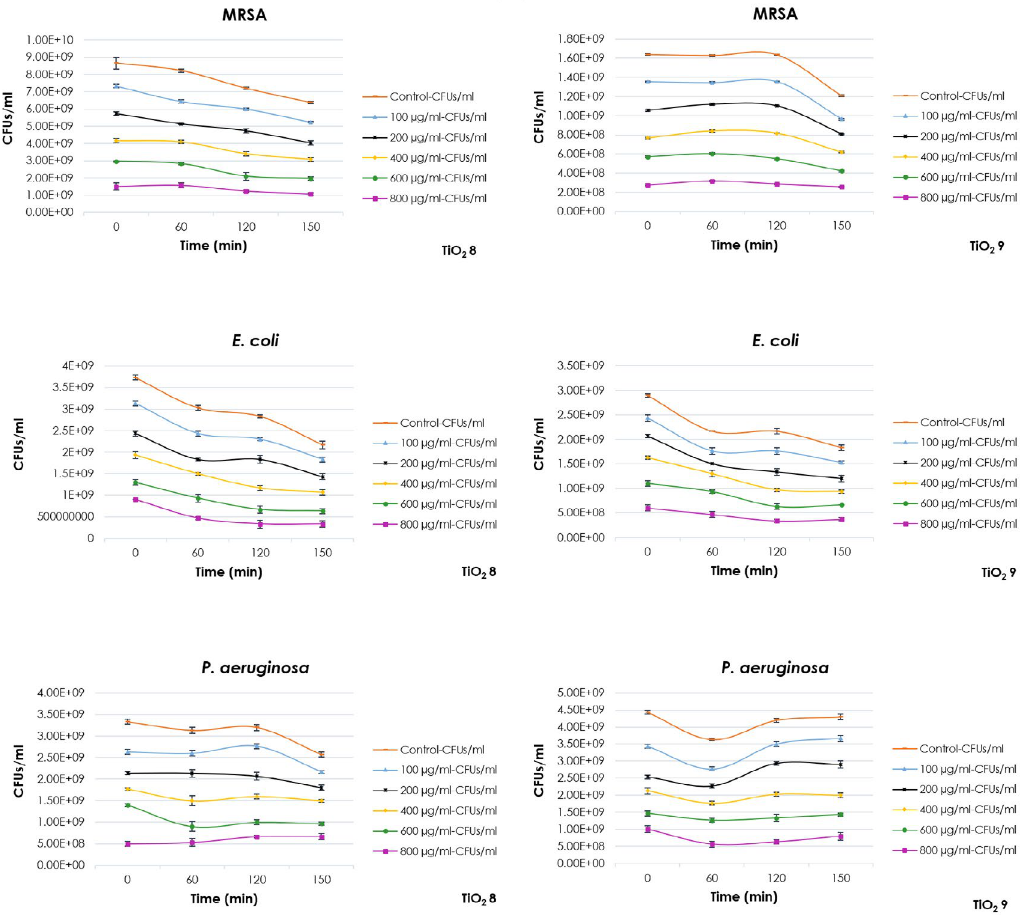
Nanoparticles with particle size more than 5 nm against MRSA, P. aeruginosa 2